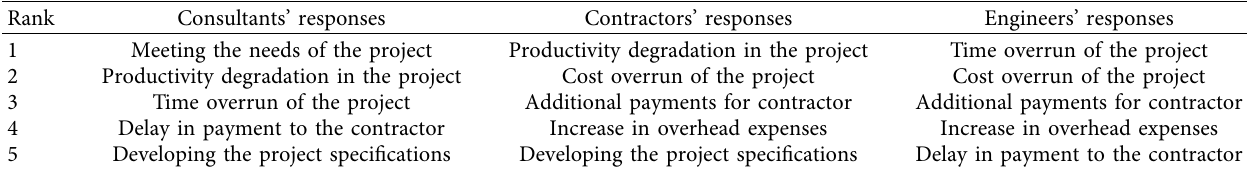
Figure 4: Frequency of impact of change orders on projects (Engineers’ Table 7: )e five most important impacts of change orders.